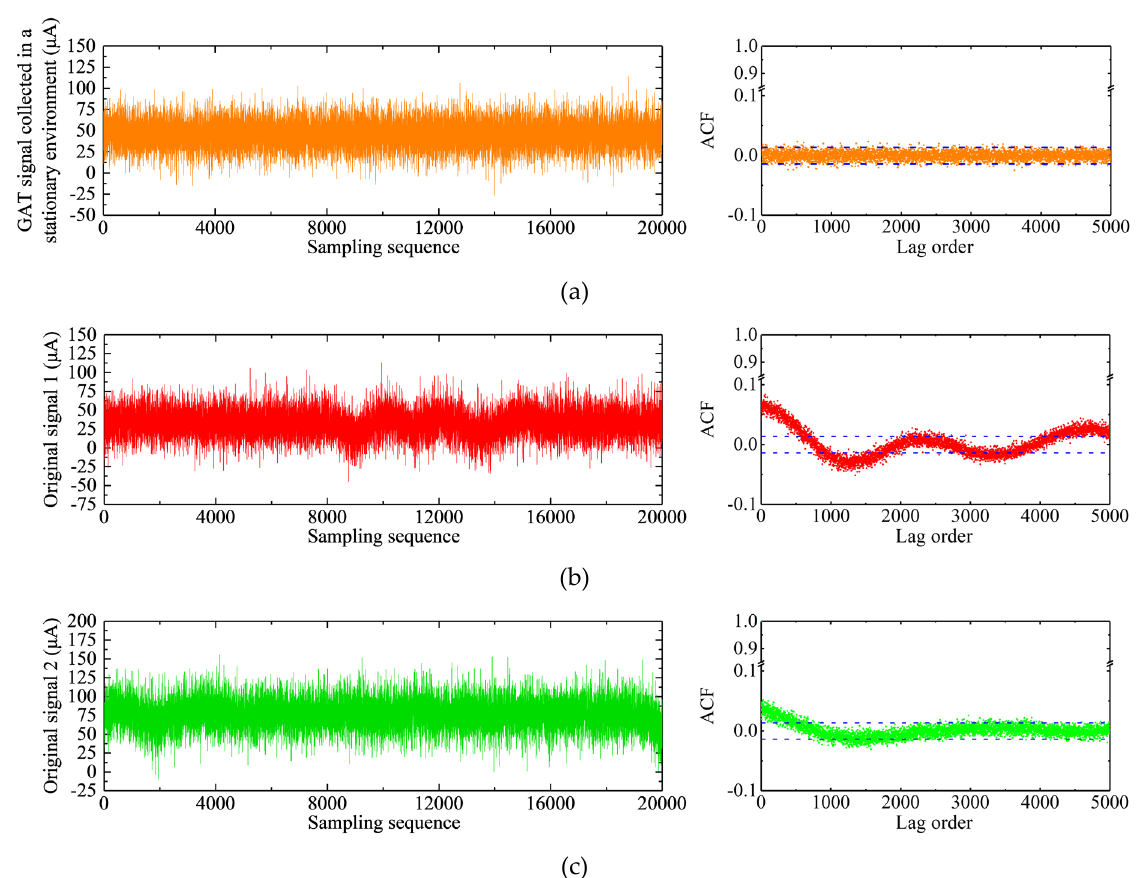
Figure 3. Time-series diagrams and the autocorrelograms of the original GAT signals: ( a ) GAT signal collected in a stationary environment; ( b ) typical jumping signal 1; ( c ) typical jumping signal 2.